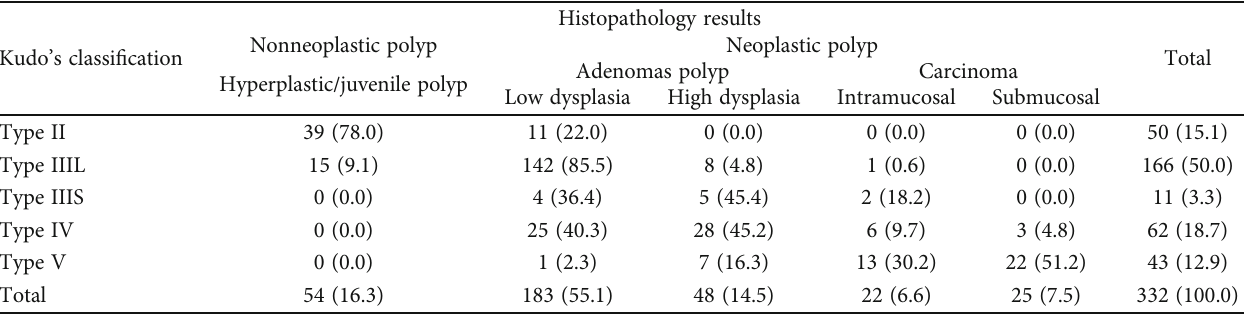
Table 3: Relationship between Kudo pit pattern classi fi cation of magnifying chromoendoscopy with Indigo carmine 0,2% and histopathology results ( n = 332 ).